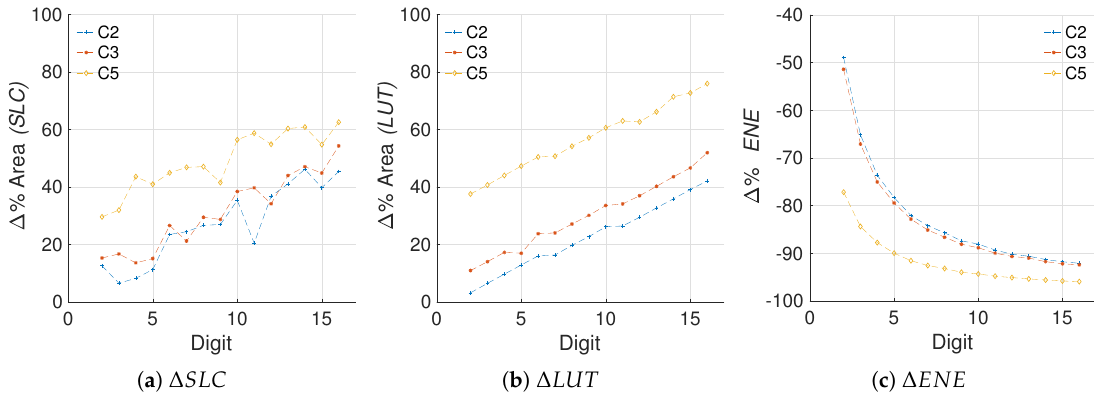
Figure 7. Percentile area and energy increments for architectures C2, C3, and C5 with reference to